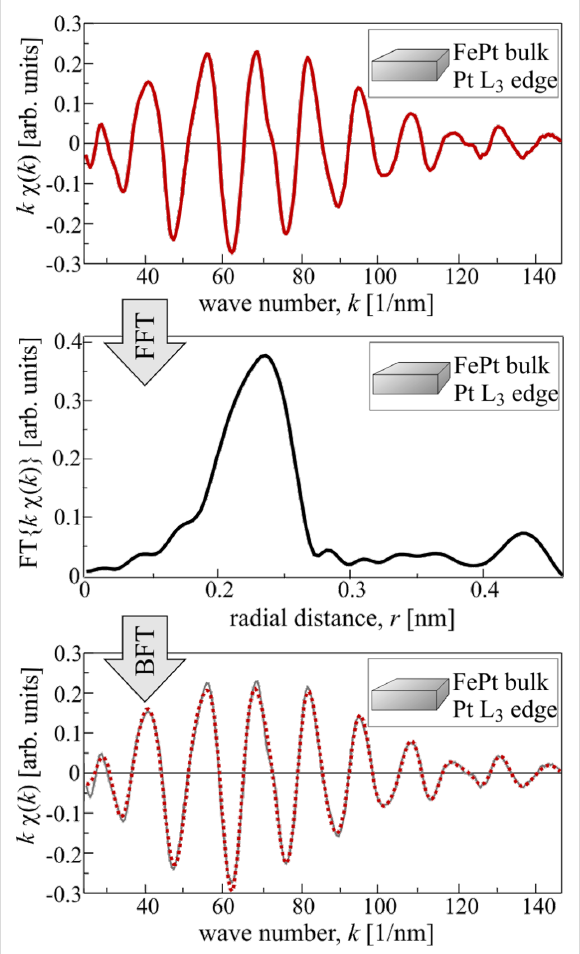
Figure 2: Experimental EXAFS data measured at the Pt L 3 absorption edge of FePt bulk material at room temperature (upper panel). The forward FT (FFT) yields a pseudo-RDF (centre) that recovers (red dotted line, lower panel) the original data (grey line, lower panel) after application of a backward FT (BFT). Details on the window functions used here can be found in the